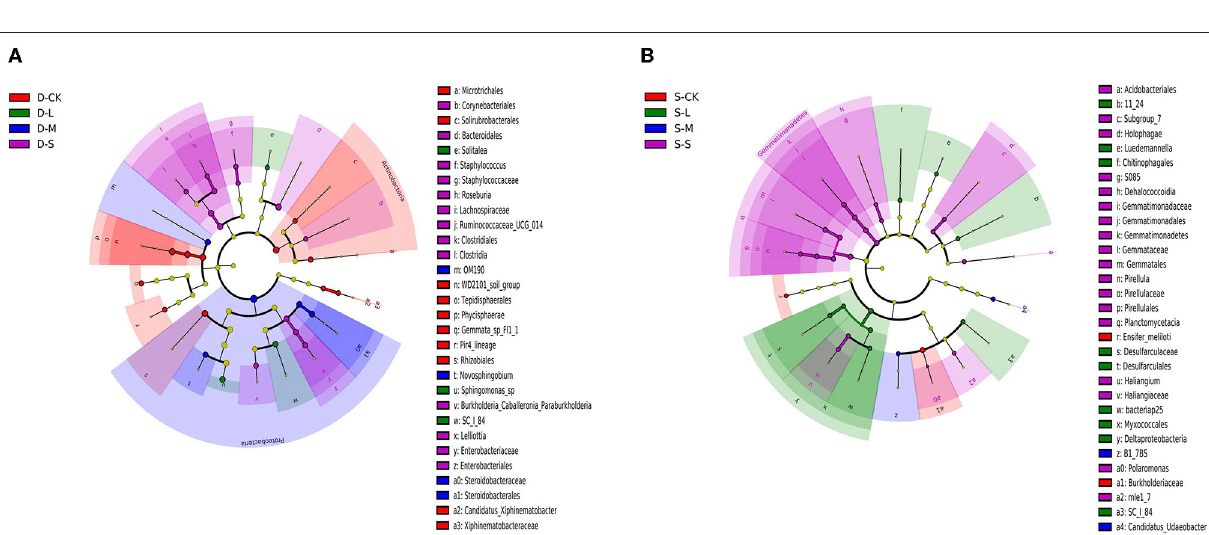
FIGURE 4 | Bacterial linear discriminant effect size (LEfSe) analysis of forest soil among forest gap sizes. Cluster tree of bacterial LEfSe analysis in (A) winter and (B) summer. Circle radiation from inner to outer of evolutionary branch figure represents the classification of the level from the phylum to species. Each small circle represents the level of a classification in different classification levels. The diameter of the circle is proportional to the relative abundance. The species without significant differences uniformly color to yellow, and the other species are colored according to the highest abundance of the species. The taxa represent the kingdom, phylum, class, order, family, and genus levels from the center outward. Only taxa meeting an LDA significance threshold of > 3 are shown. D-S, small gaps in winter; D-M, medium gaps in winter; D-L, large gaps in winter; D-CK, no forest gaps in winter; S-S, small gaps in summer; S-M, medium gaps in summer; S-L, large gaps in summer; S-CK, no forest gaps in